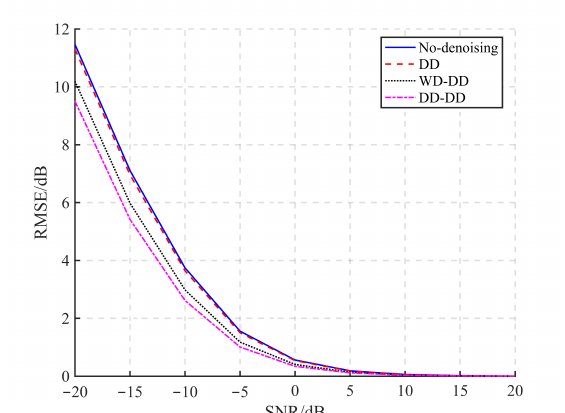
Figure 7. The variation of RMSE with the SNR of the received data.